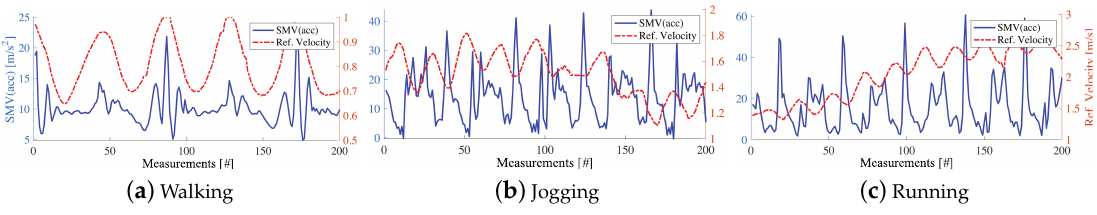
Figure 8. Raw acc signals: SMV (blue), v ref